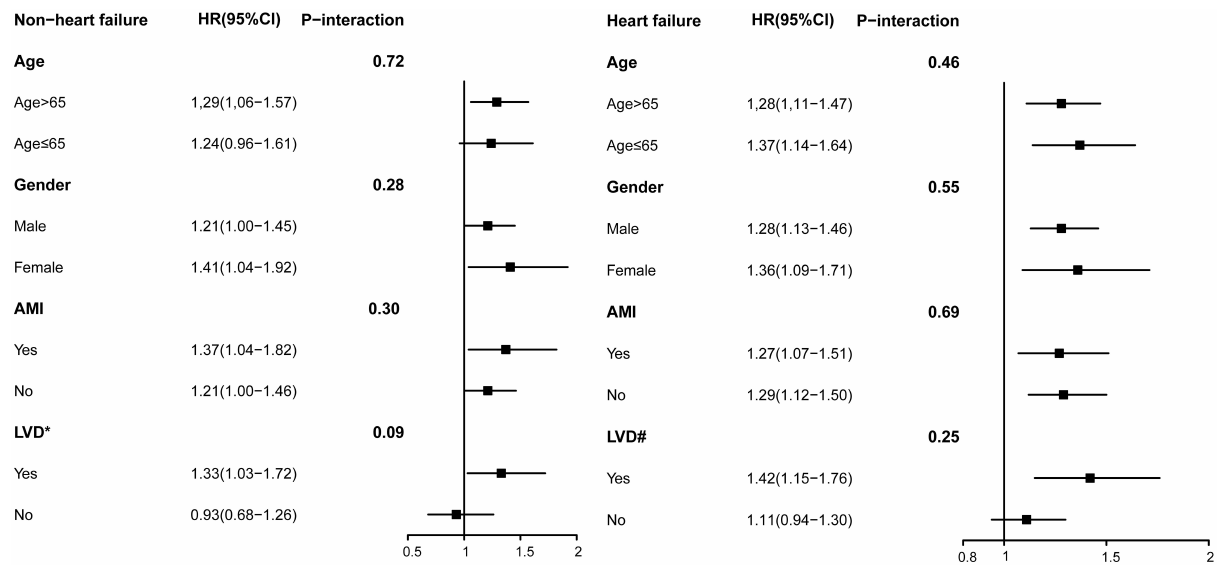
FIGURE 3 | Subgroup analysis of moderate or severe MR among in patients undergoing percutaneous coronary intervention (PCI) without mitral valve surgery. Model 3 for long-term mortality. *LVEF < 64(median among non-HF); # LVEF < 47(median among